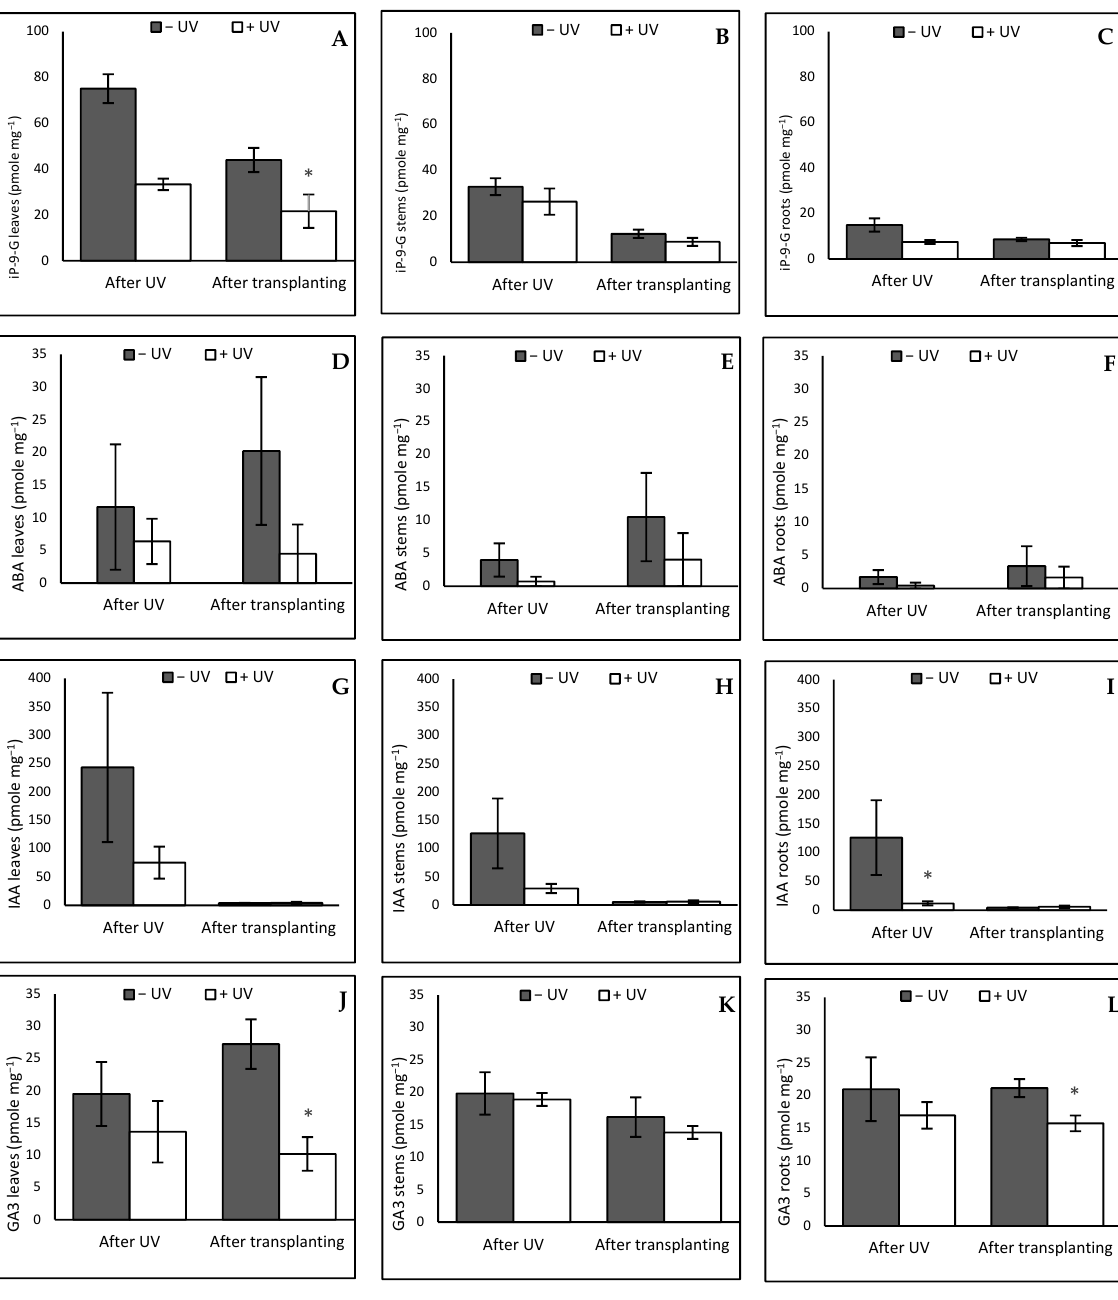
Figure 11. In the graphs are represented the level of hormones IPG9 ( A – C ), ABA ( D – F ), IAA ( G – I ) and GA3( J – L ). Hormones were measured respectively in the leaves (graphs on the left), in the stems (graphs in the middle) and in the roots (graphs on the right). Asterisks indicate a significant difference between the UV treatments with p < 0.05 (*).